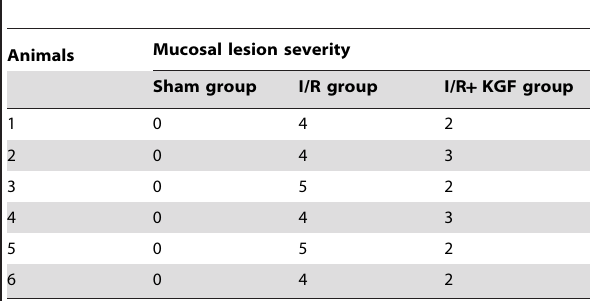
Table 1. Classification of mucosa lesions in the experimental animals*.